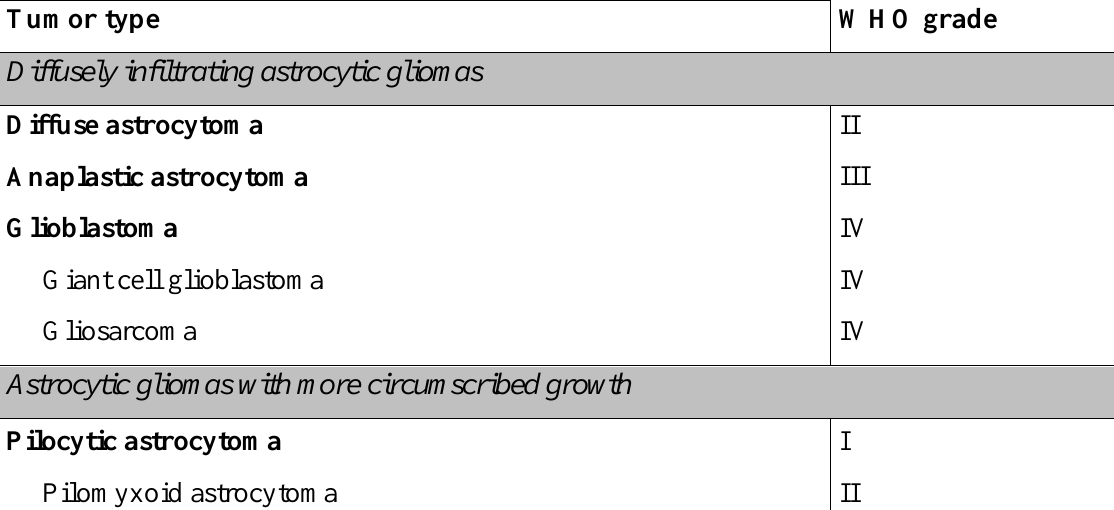
Table 1. Classification and grading of the main glioma subtypes according to the WHO classification of tumors of the central nervous system